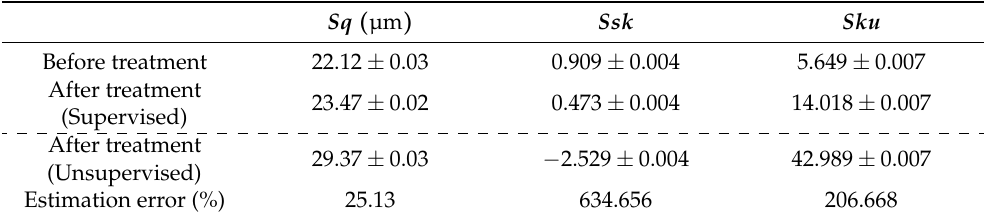
Table 2. Surface parameters of the mold sample before and after the treatment: computation in the corrected domain (supervised by the intensity map); errors in the parameters caused by the bias in the